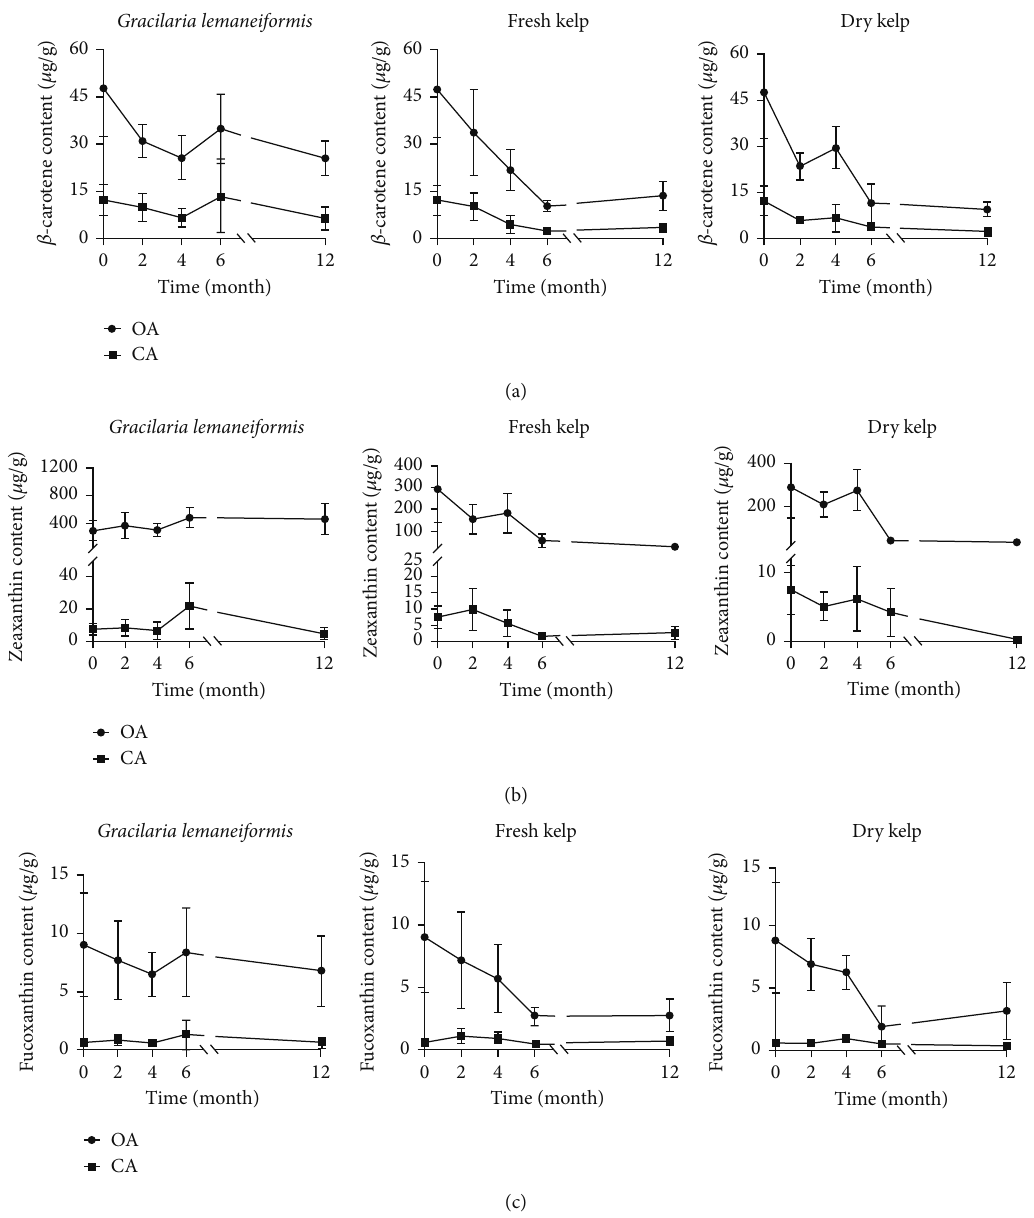
Figure 3: Variations in carotenoid content in H. gigantea muscles with di ff erent colors under various diets for 12